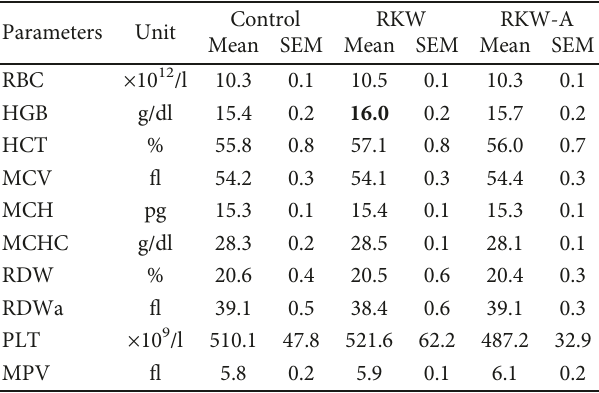
Table 1: Blood hematological analysis. Analysis was performed in the o ff spring of mothers fed during pregnancy and lactation with water (RKW) or hydroalcoholic (RKW-A) extract of Rhodiola kirilowii. Bold font indicates statistically signi fi cant di ff erences in comparison to control group ( P < 0 05